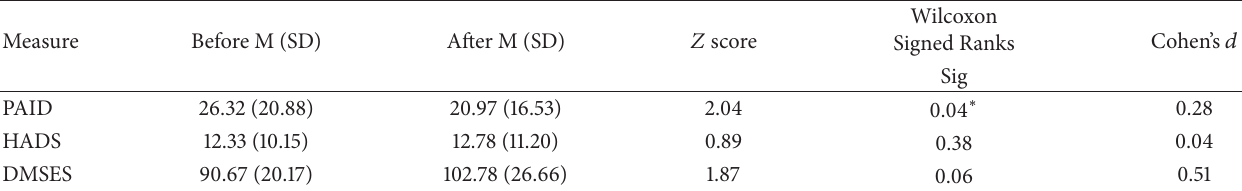
Table 4: Outcome measures at baseline and 6-week